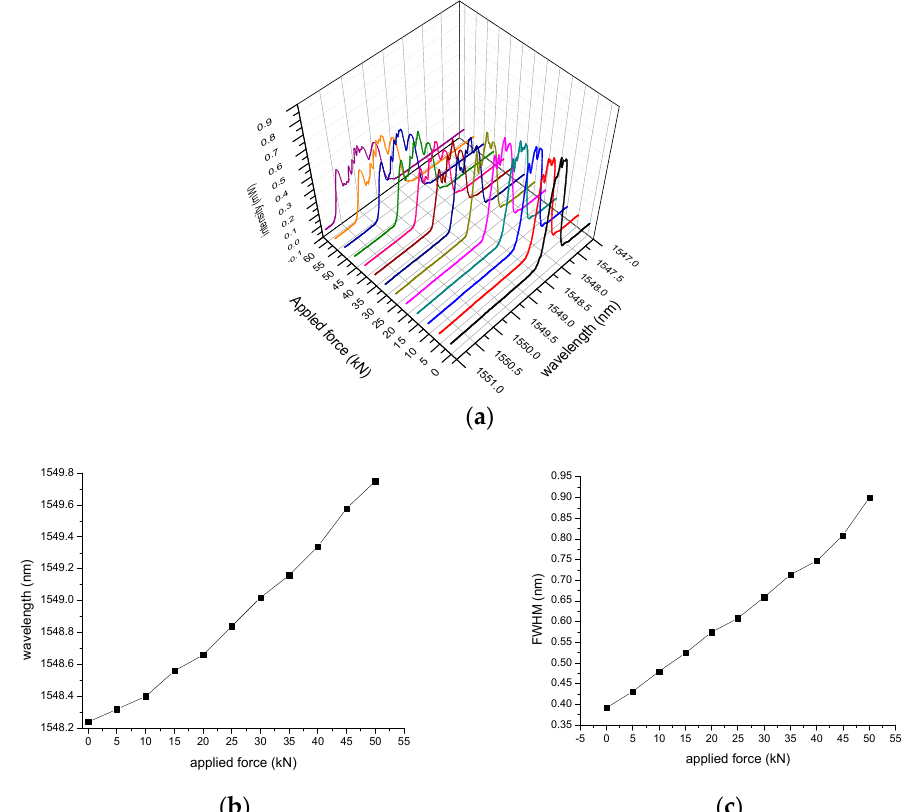
Figure 9. ( a ) 25 mm FBG spectral response with applied force in the composite patch. ( b ) Peak spectral response with applied force. ( c ) FWHM spectral response with applied force.